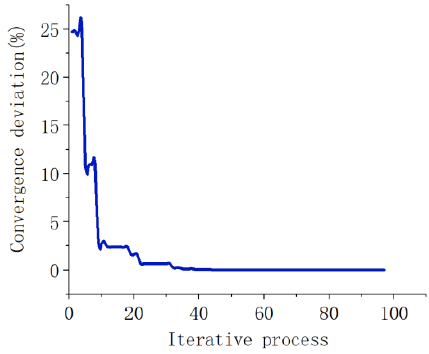
Figure 4. Particle swarm iteration process.